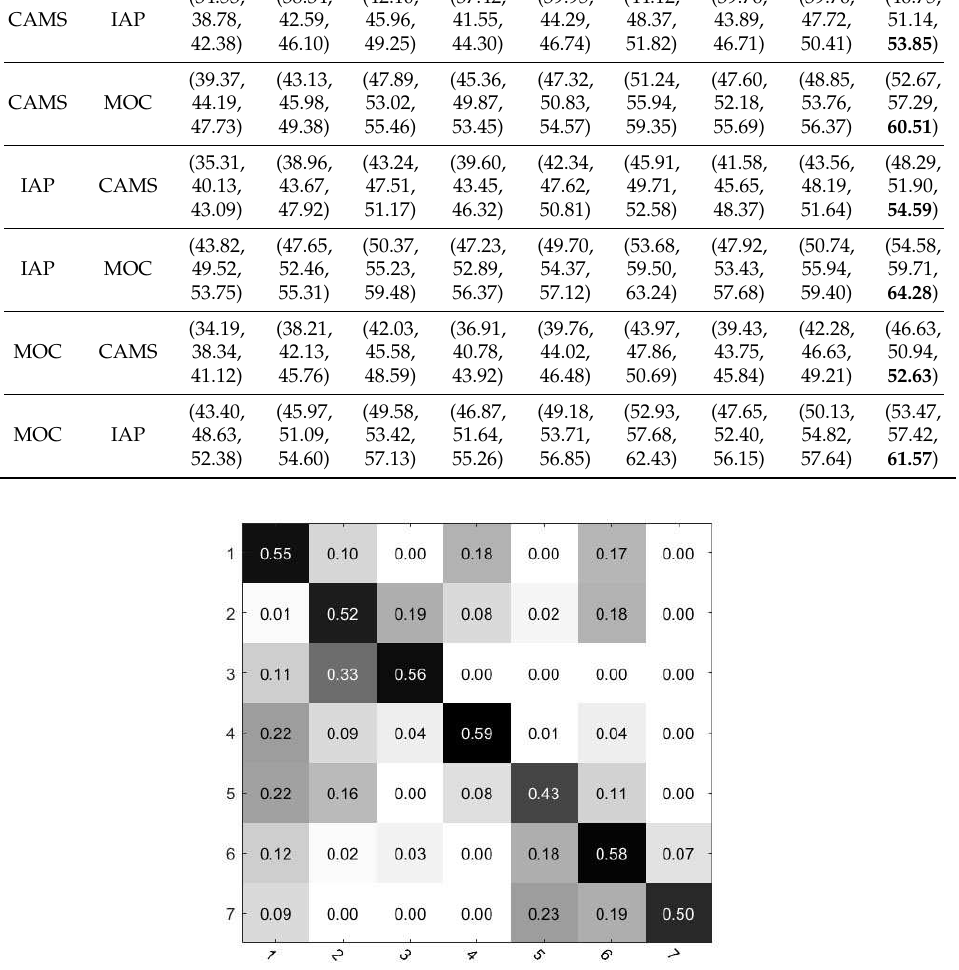
Figure 9. The confusion matrix for the best case TCLBP + DML (without IGC and FN) in the case of IAP to MOC domain shift. The Arabic numbers denote 1: Cumulus, 2: Cirrus and cirrostratus, 3: Cirrocumulus and altocumulus, 4: Clear sky, 5: Stratocumulus, 6: Stratus and